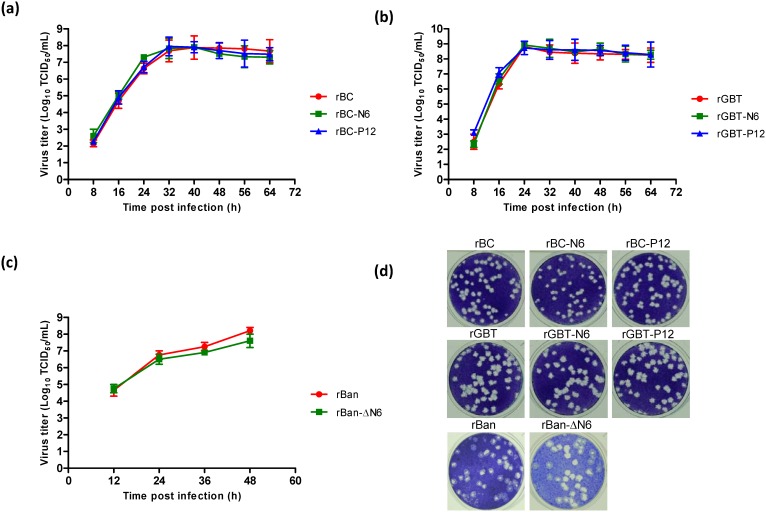
Growth kinetics and plaque morphology of recombinant NDV strains in chicken embryo fibroblast (DF-1) cells.The multi-cycle growth kinetics of recombinant BC (rBC) (a), GBT (rGBT) (b) and Ban (rBan) (c) in parallel with their mutant viruses in DF-1 cells. Values are the means of triplicate wells. Error bars indicate mean±SEM. (d) Plaque morphology of rBC, rGBT and rBan group viruses in DF-1 cells. Note the larger plaque size of GBT and Ban viruses compared to BC viruses, and the similarity between the mutant viruses and their parents.